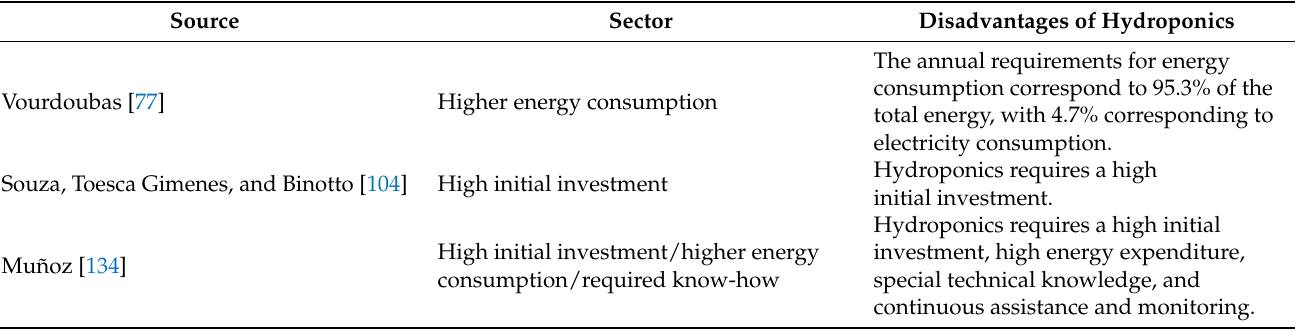
Table 6. Disadvantages of hydroponic